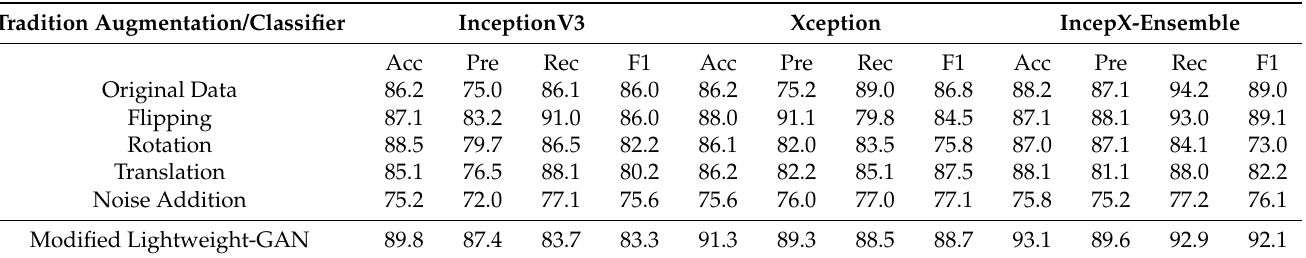
Table 6. Accuracy, precision, recall, and F1-score of different classification using traditional augmen- tation methods and a combination of original with synthetic data.